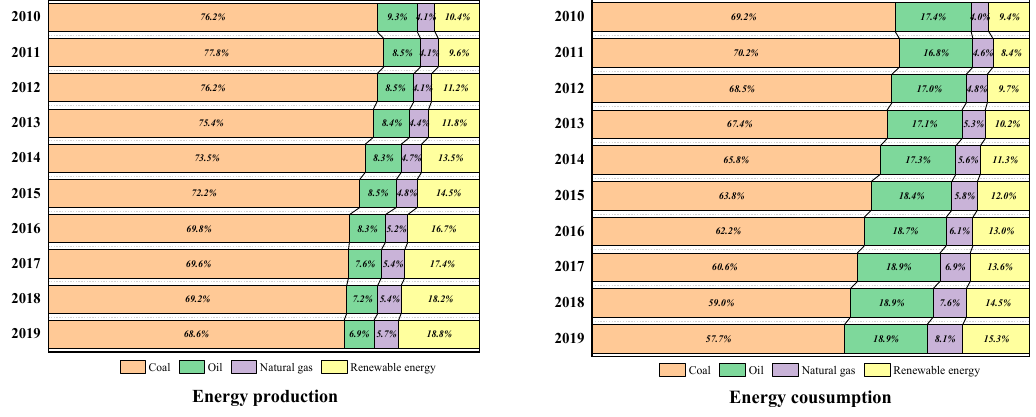
Figure 1. Energy production and consumption in China from 2010 to 2019.